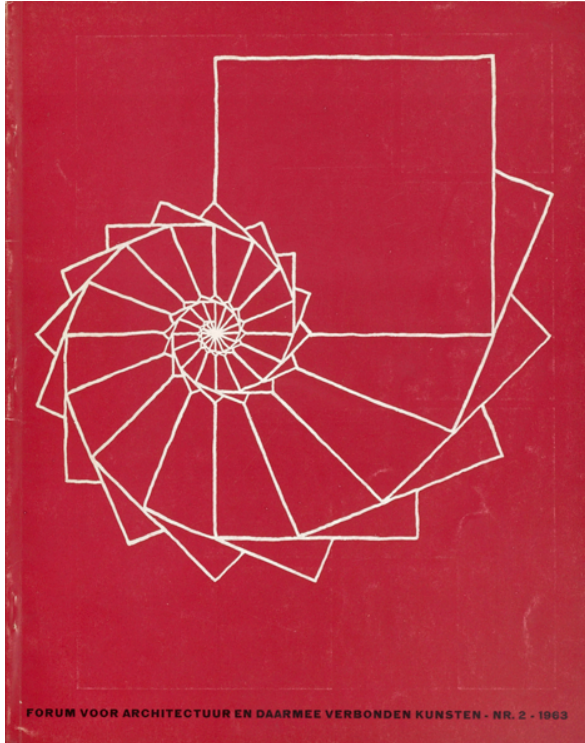
Page of Forum 1963, n. 2 “Architecture as an Instru- ment of Man’s Self-Realization.” Forum voor Architec- tuur en Daarmee Verbonden Kunsten 17, n. 2 (1963):